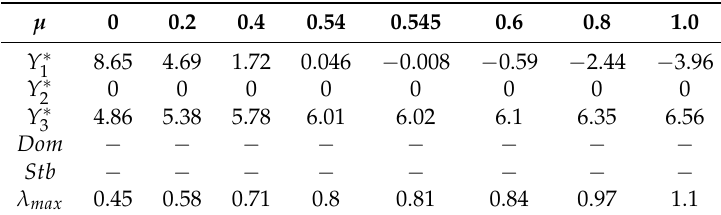
Table 4. The ( 13 ) -profitability states.